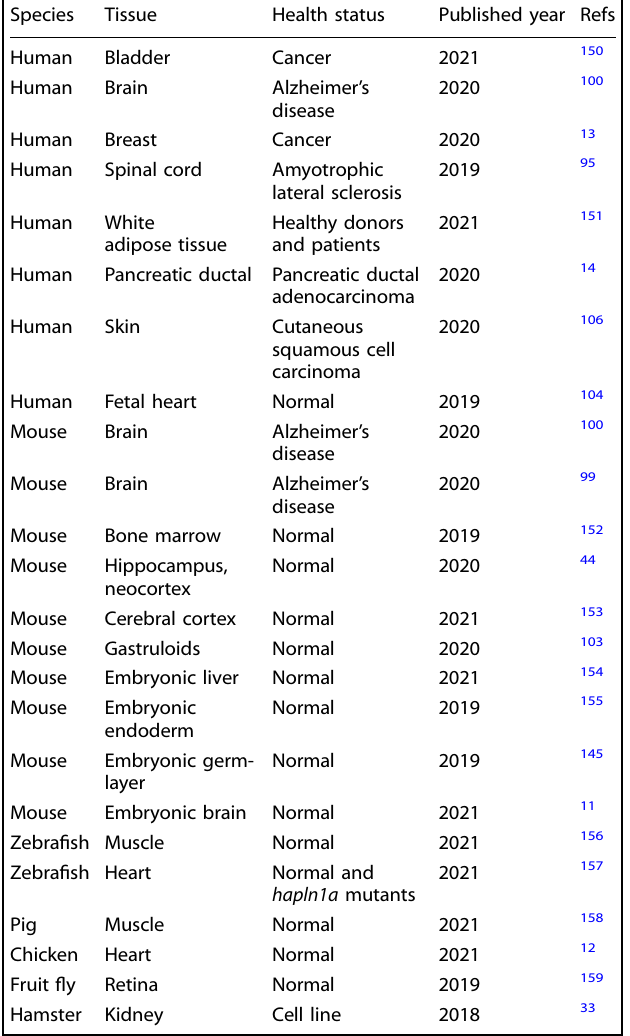
Table 4. Representative studies of ST on multiple species Table 5. Representative ST research on human